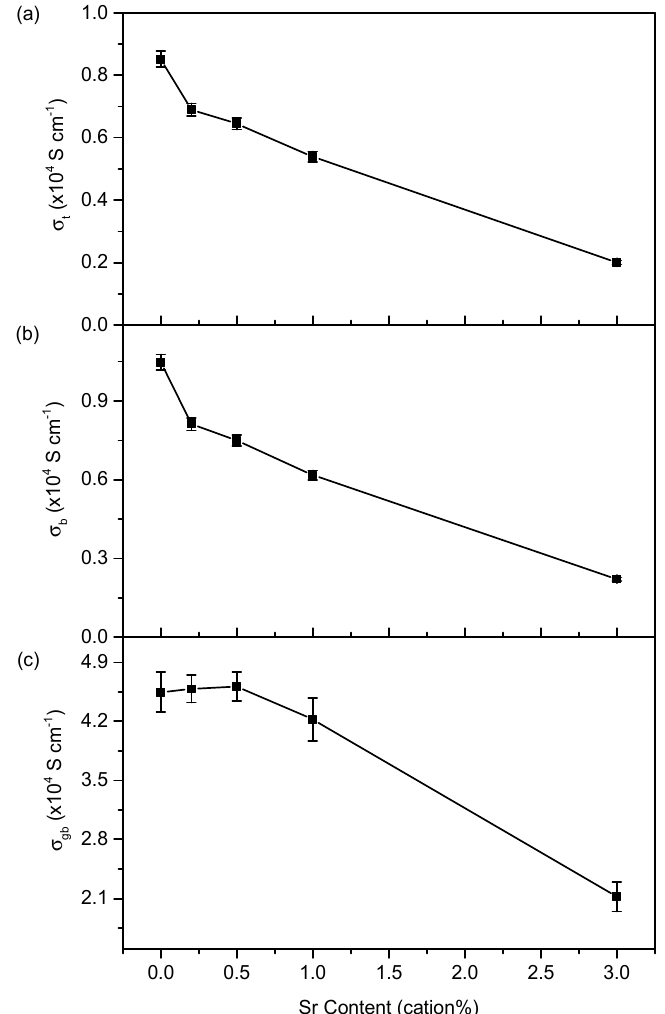
Figure 11. Plots of the variation of ( a ) total, ( b ) bulk and ( c ) grain boundary conductivities with Sr content for all Ce 0.8-x Sm 0.2 Sr x O 2- δ samples measured at 300 °C. content for all Ce 0.8 − x Sm 0.2 Sr x O 2 − δ samples measured at 300